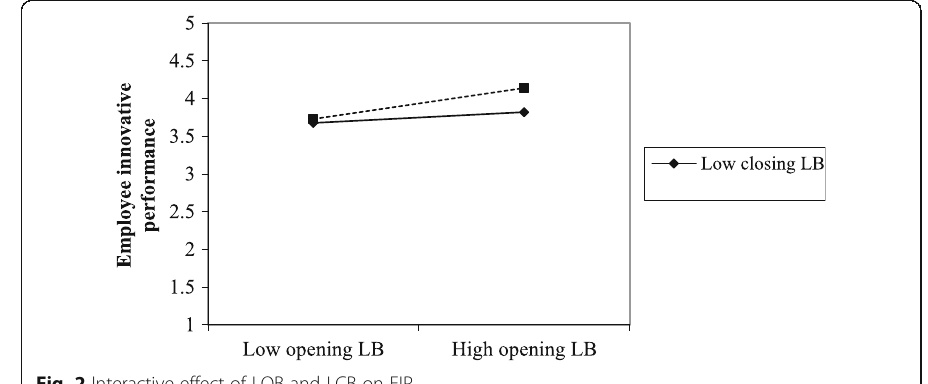
Fig. 2 Interactive effect of LOB and LCB on